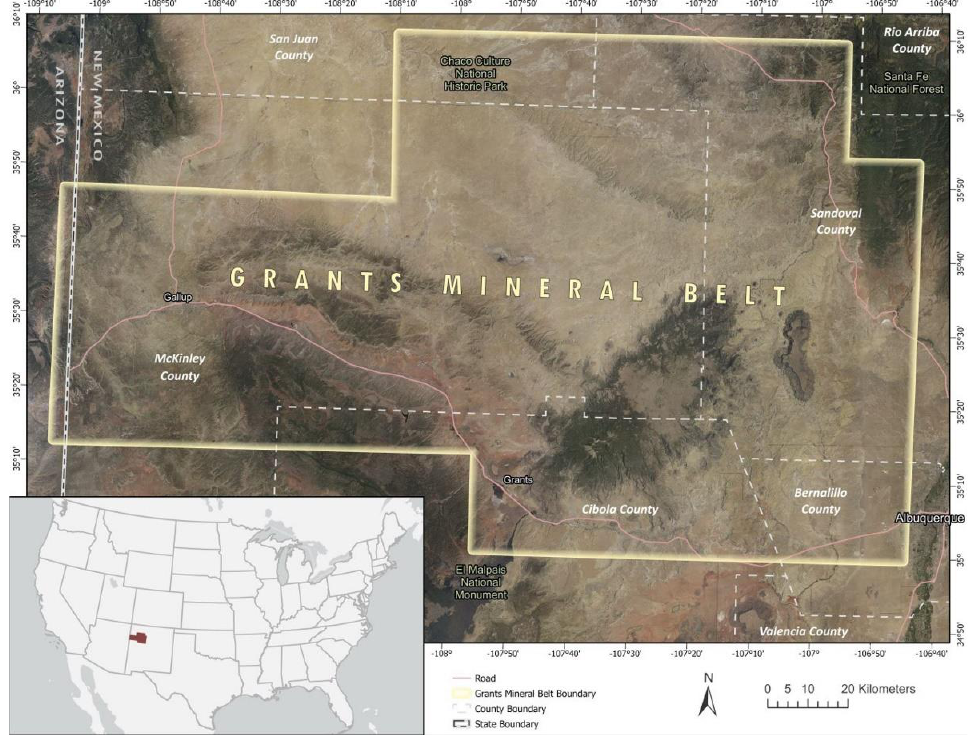
Figure 6. The location of Grants Mineral Belt. It is primarily located in the State of New Mexico but a tiny portion of the Grants Mineral Belt is located in the State of Arizona.